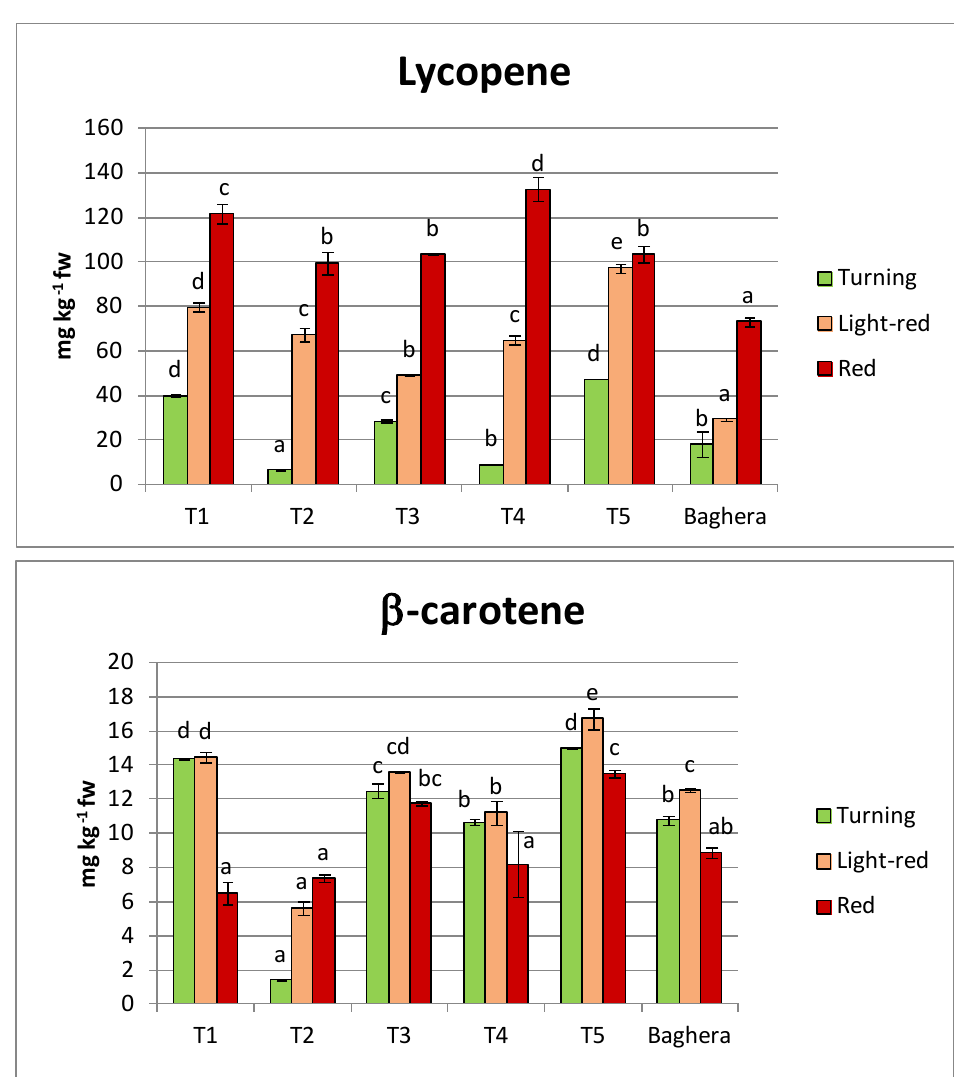
Figure 5. Tomato carotenoids ( lycopene and β -carotene ) content. For each ripening stage, different letters represent significant differences according to Tukey’s test ( p < 0.05). Mean values and standard deviation .